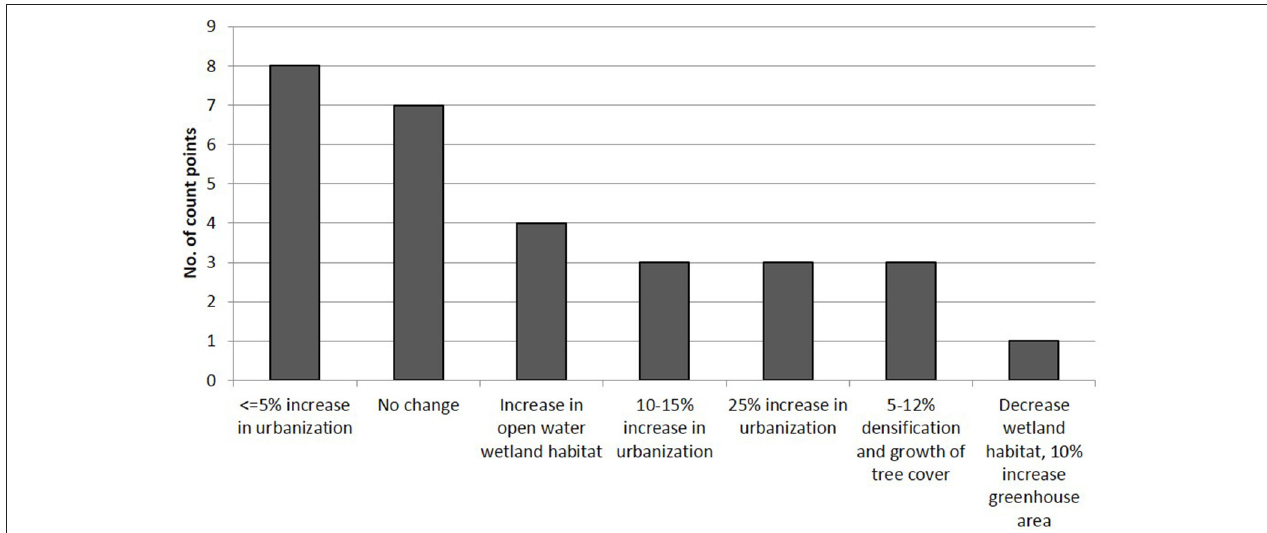
FIGURE 4 | Mean annual maximum, mean and minimum temperatures, and tendency lines between 1962 and 2015. Data from Eldorado airport located in the CBC circle.